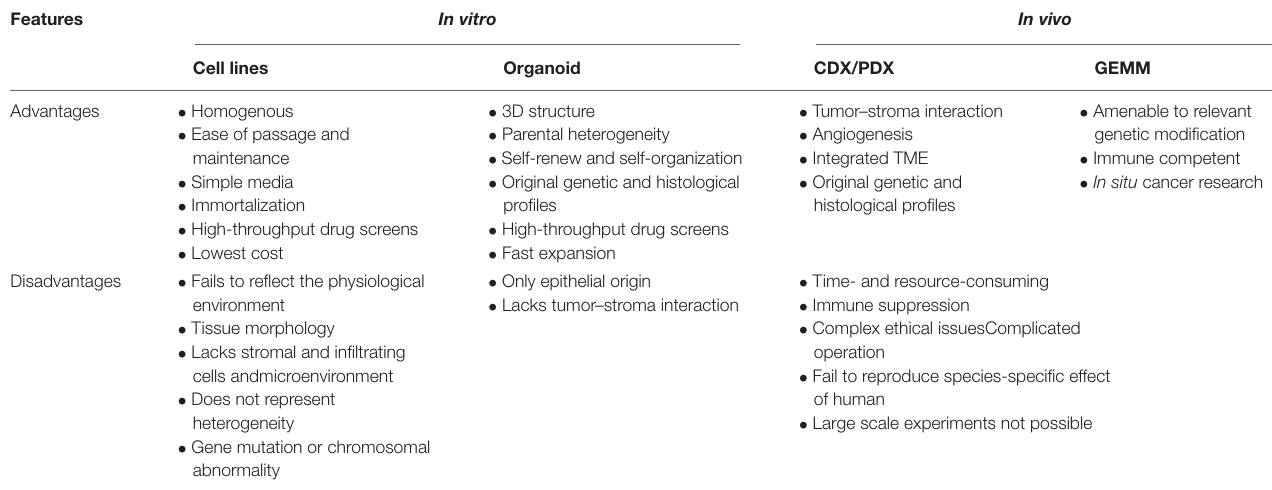
TABLE 1 | Advantages and disadvantages of research